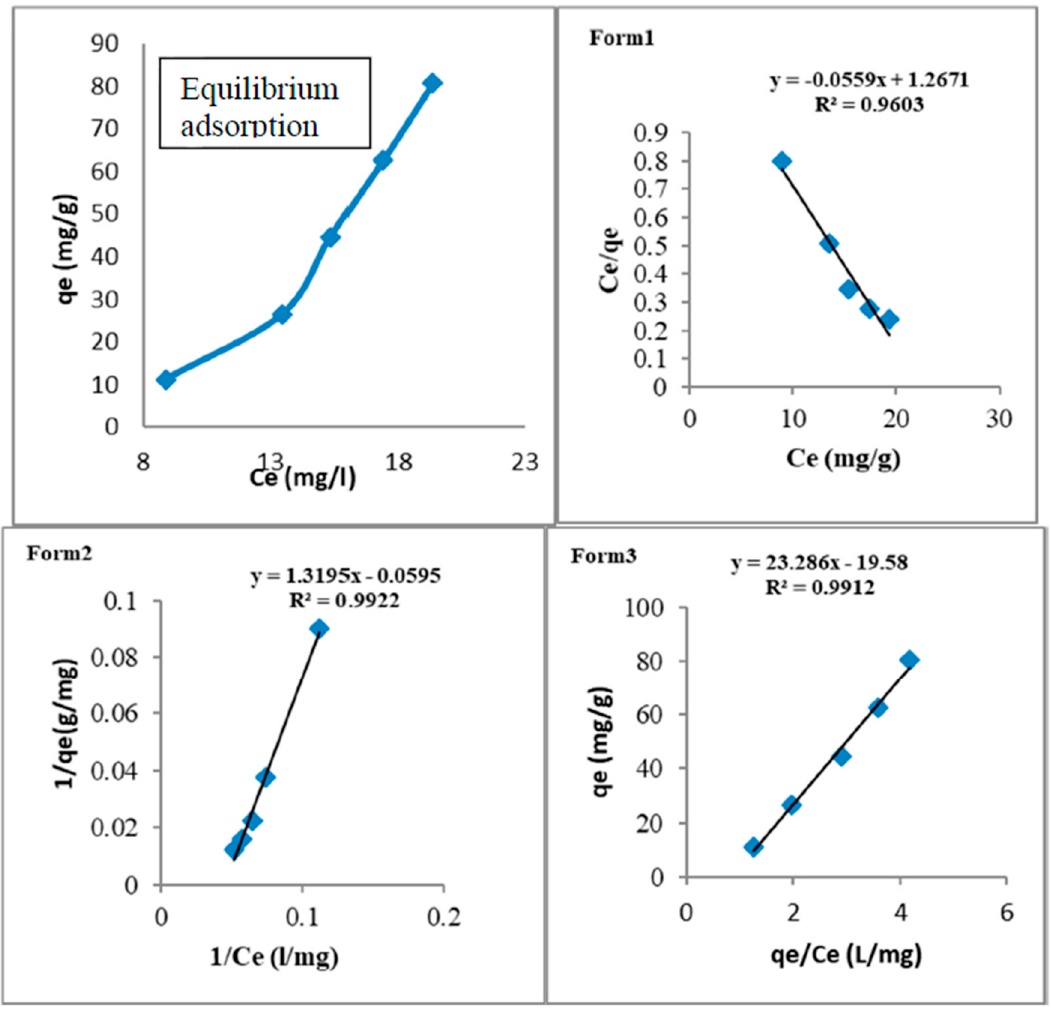
Figure 9. Equilibrium adsorption and the three forms of Langmuir isotherm for lead adsorption into CDs.